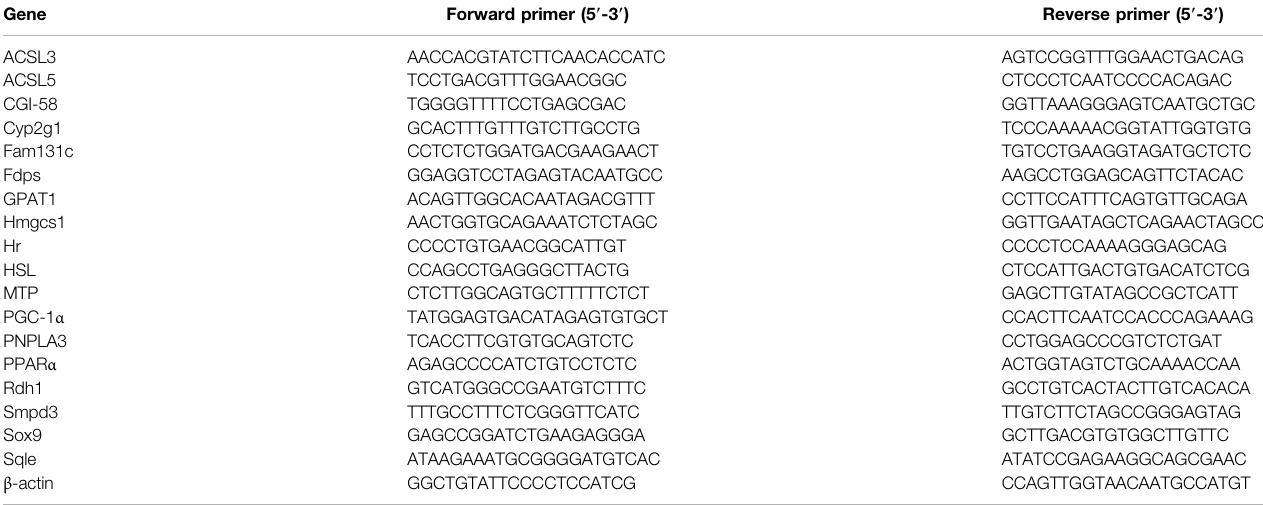
TABLE 1 | The sequence of the primers for